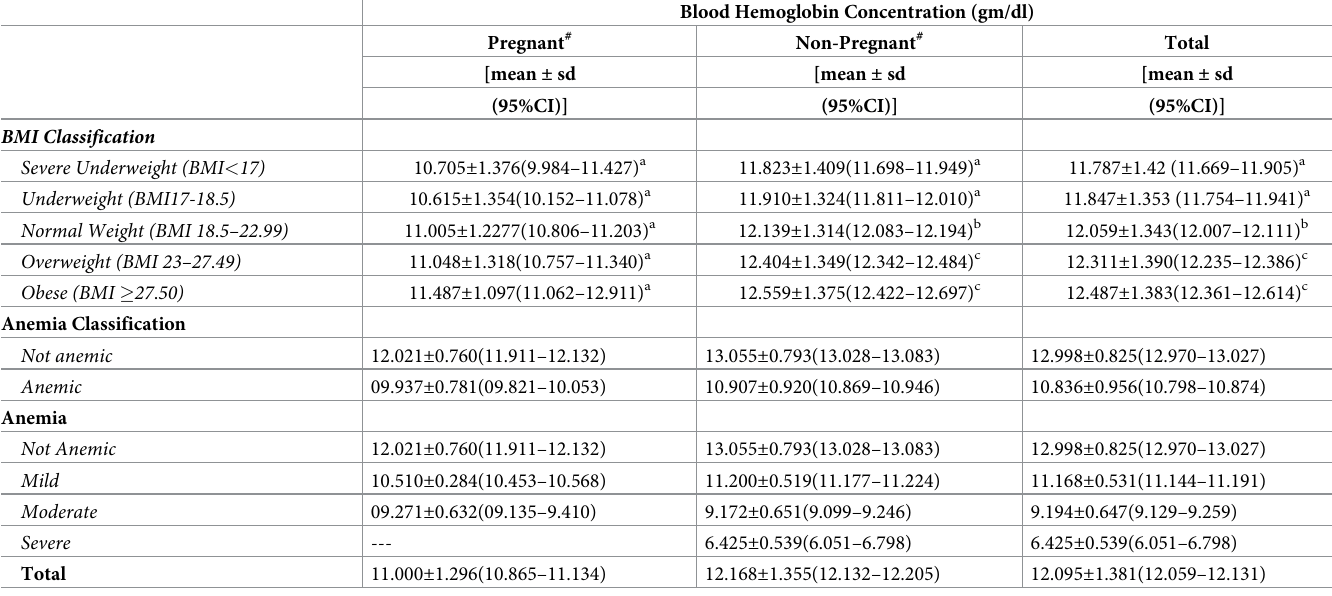
N.B.: # indicate hemoglobin level between pregnant and non-pregnant women is significantly different (p � 0.0001), Each column with different superscript indicates significant difference (p � 0.05) in hemoglobin level.